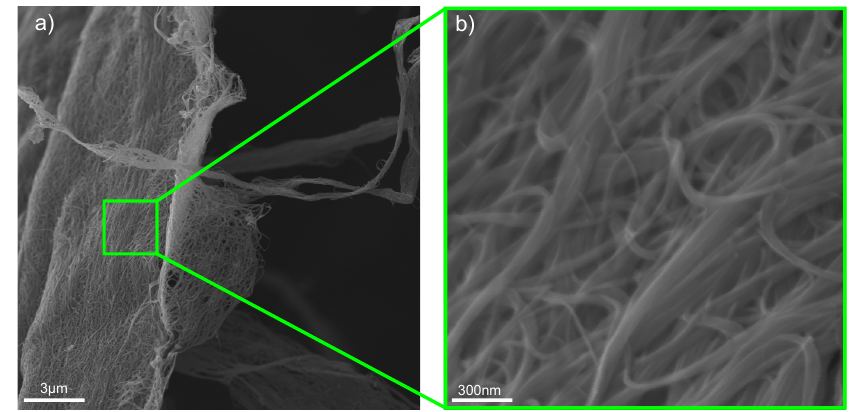
Figure A10. SEM images for Tuball purified at magnifications of ( a ) 10k and ( b ) 150k.